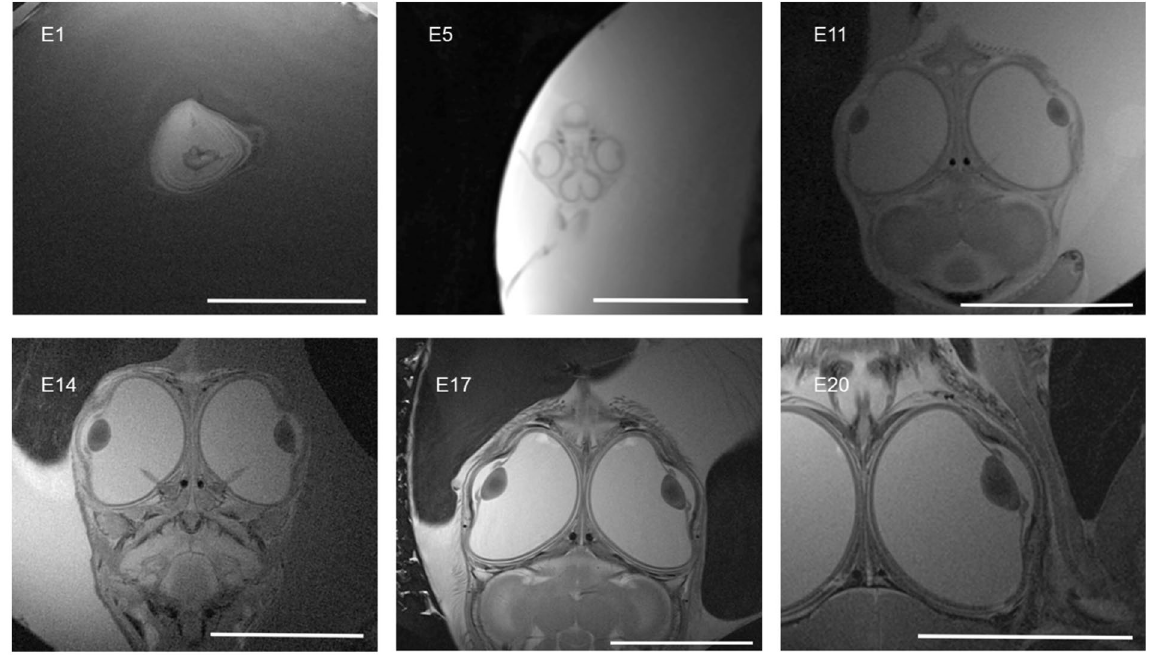
Figure 4. Examples of T2-weighted in vivo MR images (TE/TR: 48/2100 ms, FoV: 38 × 38 mm, slice thickness: 700 µ m; matrix size: 512 × 512 interpolated to 1024 × 1024; in-plane resolution: 74 × 74 µ m) of a chick embryo in ovo at different time points (E1–E20) during the development cycle. Each scale bar represents 10